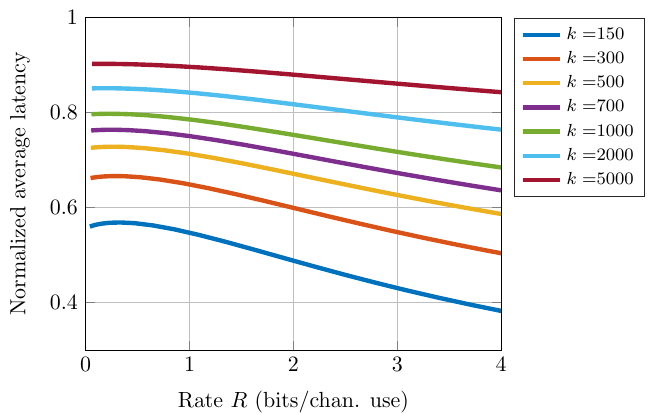
Fig. 5 Normalized average latency as a function of channel code rate for various information block size k and a BLER ǫ = 10 − 5